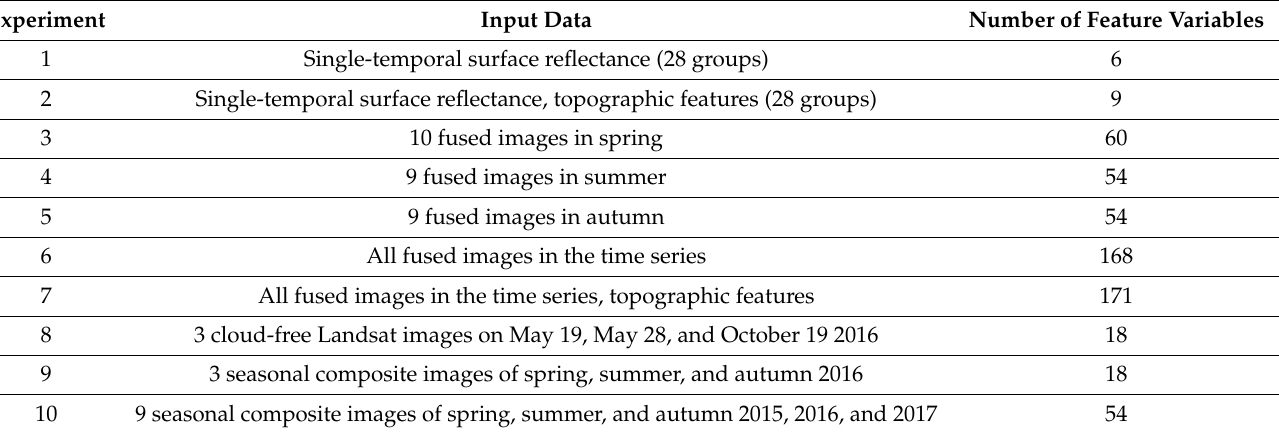
Table 3. The feature combinations of seven